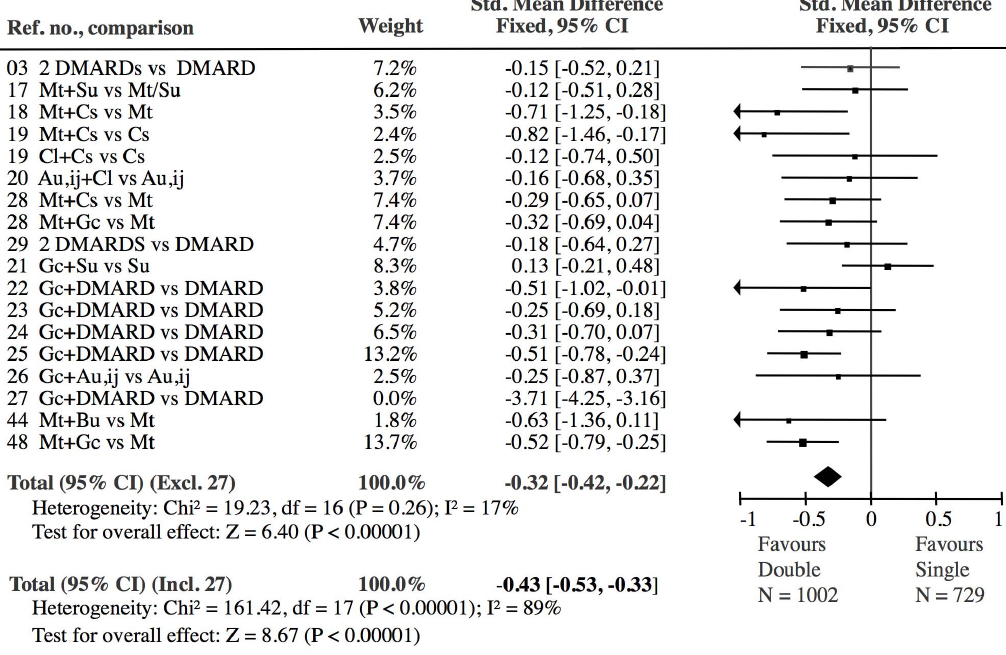
Figure 4. Double DMARD versus single DMARD: The effect of the Double DMARD treatment was highly significant (Z=6.40). All 18 Double studies showed heterogeneity (I 2 =89%). The exclusion of one reference [27], which had an extreme effect ( 2 3.71 SMD), eliminated the